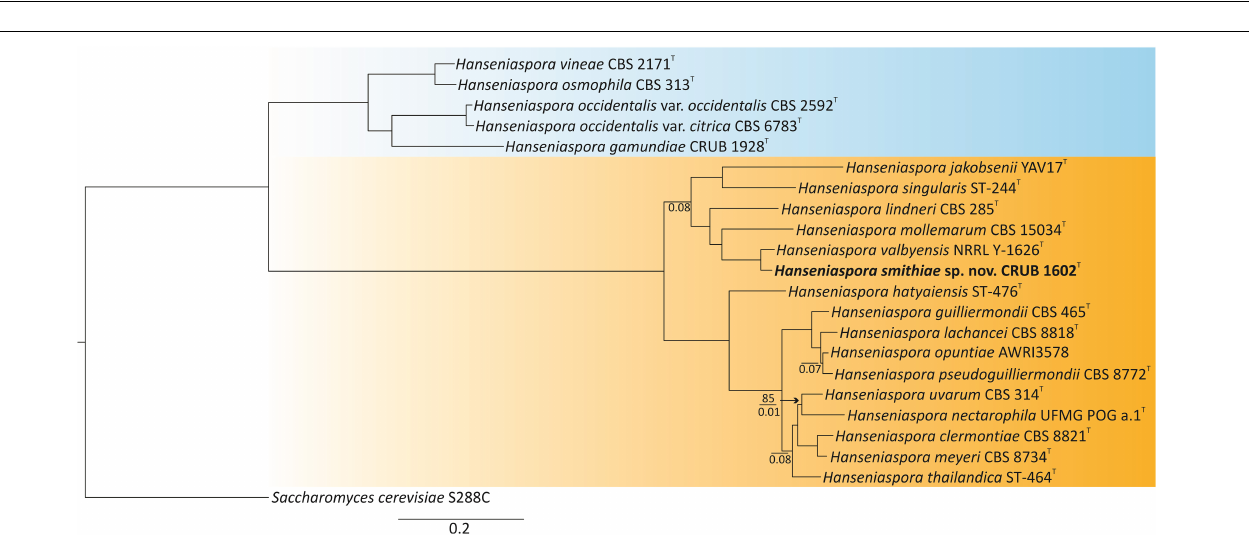
FIGURE 1 | Maximum parsimony network for H. smithiae (6 strains), H. valbyensis (9 strains), and H. lindneri (one strain) based on the concatenated sequences of the actin gene and of the ITS and D1/D2 regions of rRNA (2,190 bp). Boxes (nodes subtended by multiple edges) indicate incongruence in the data. The numbers on the branches show the number of nucleotide substitutions and the bootstrap values (%).